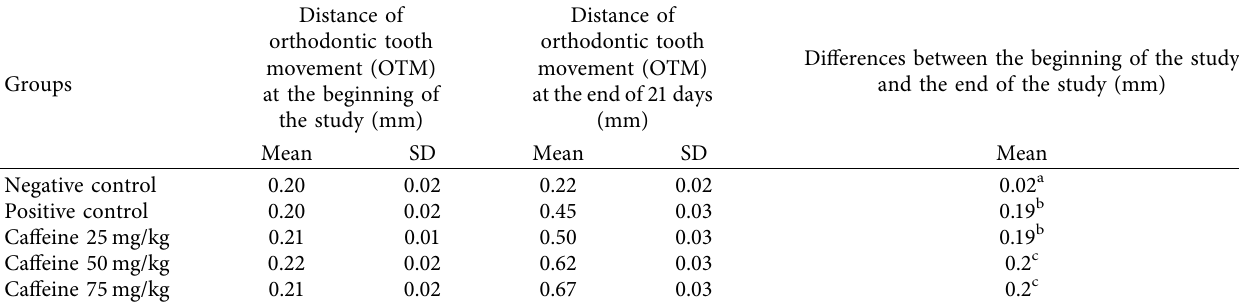
Table 1: Mean and standard deviations of orthodontic tooth movement (OTM) in millimeters in the five experimental groups. Distance of orthodontic tooth Groups